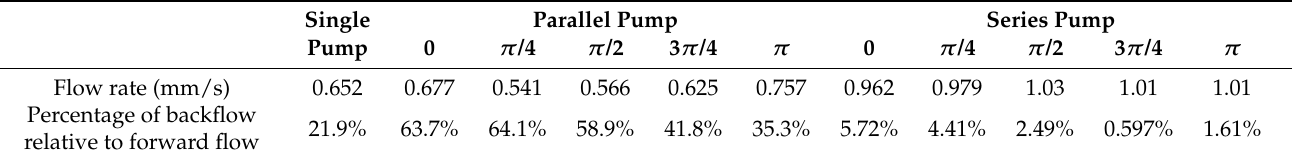
Table 1. Comparison of overall experimental